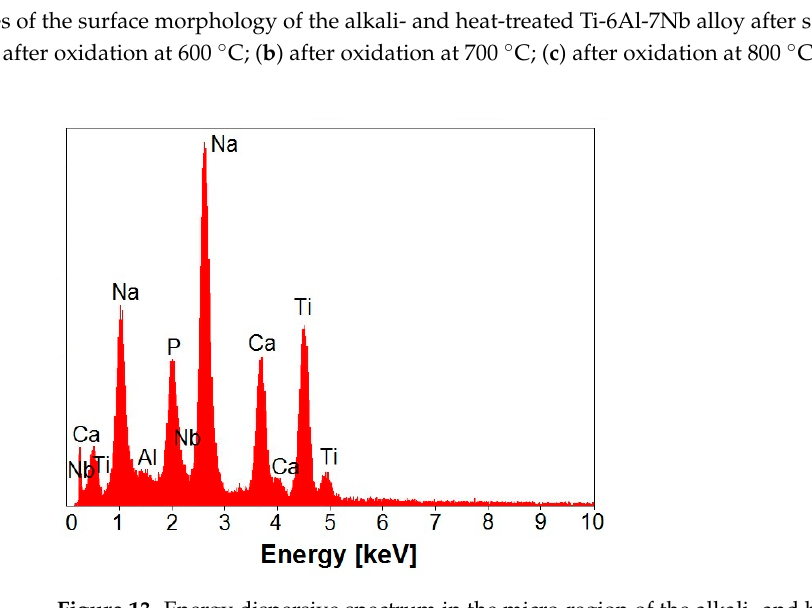
Figure 13. Energy dispersive spectrum in the micro ‐ region of the alkali ‐ and heat ‐